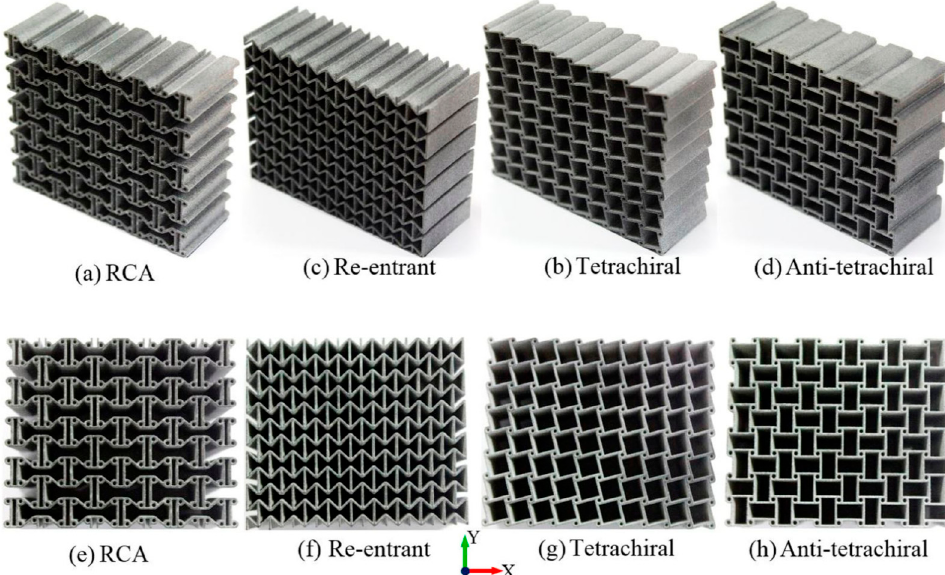
Figure 2. Auxetic cellular structures of different geometric shapes were printed with PA 12; ( a , e ) Re-entrant chiral auxetic (RCA); ( c , f ) Re-entrant; ( b , g ) Tetrachiral, ( d , h ) Anti-tetrachiral. Reprinted with permission from ref. [199] . Copyright 2020, Taylor and Francis.